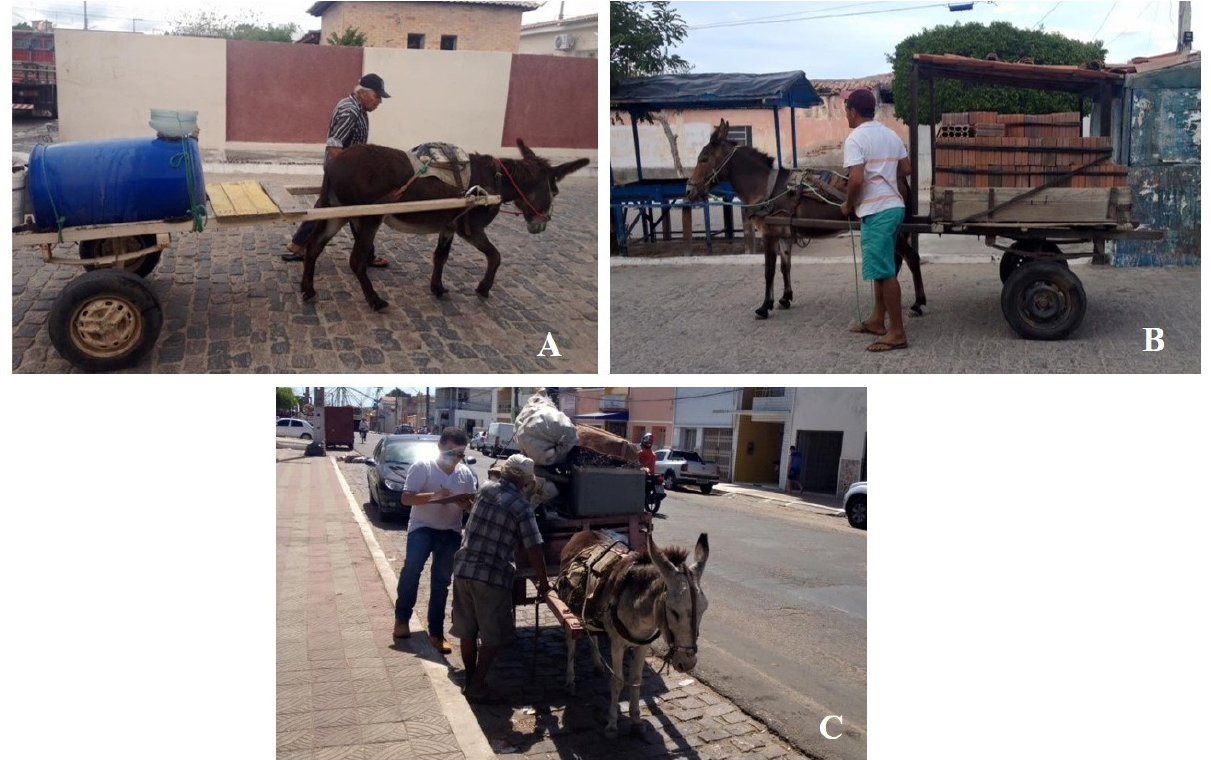
Figure 2. Owners were approached for consent, questionnaire application and blood collection of traction equids during urban work in the state of Paraíba, Northeastern Brazil. ( A ): Traction donkey transporting a water tank for human and animal consumption; ( B ): Traction mule transporting bricks for civil construction; ( C ): Traction donkey transporting recyclable